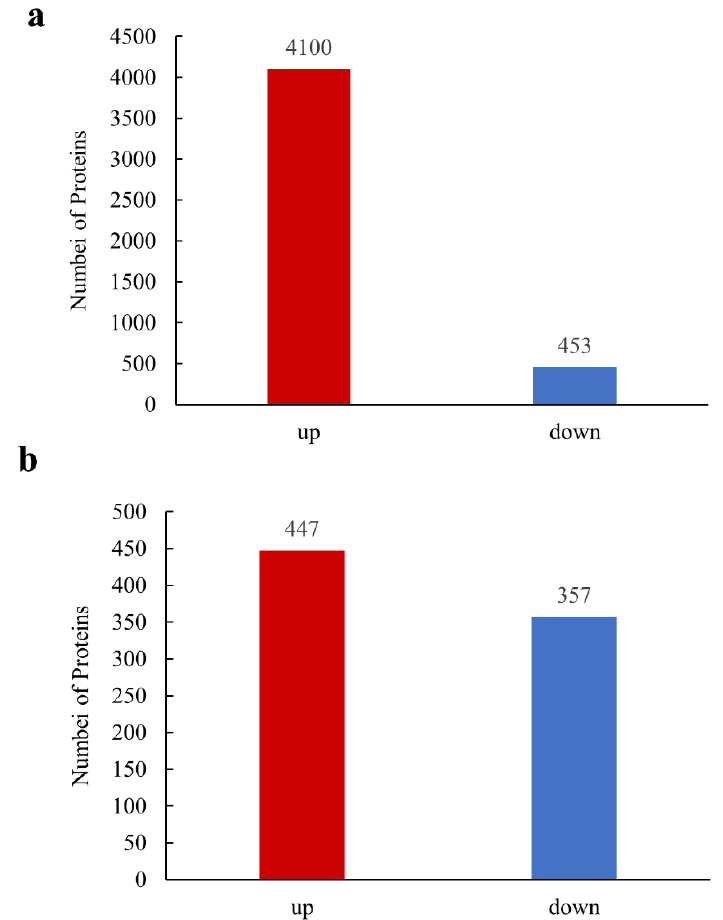
Figure 2. Significant differentially expressed proteins (DEPs). ( a ) Up-or downregulated DEPs in response to T. controversa infection; ( b ) up-or downregulated DEPs in response to T. foetida infection.